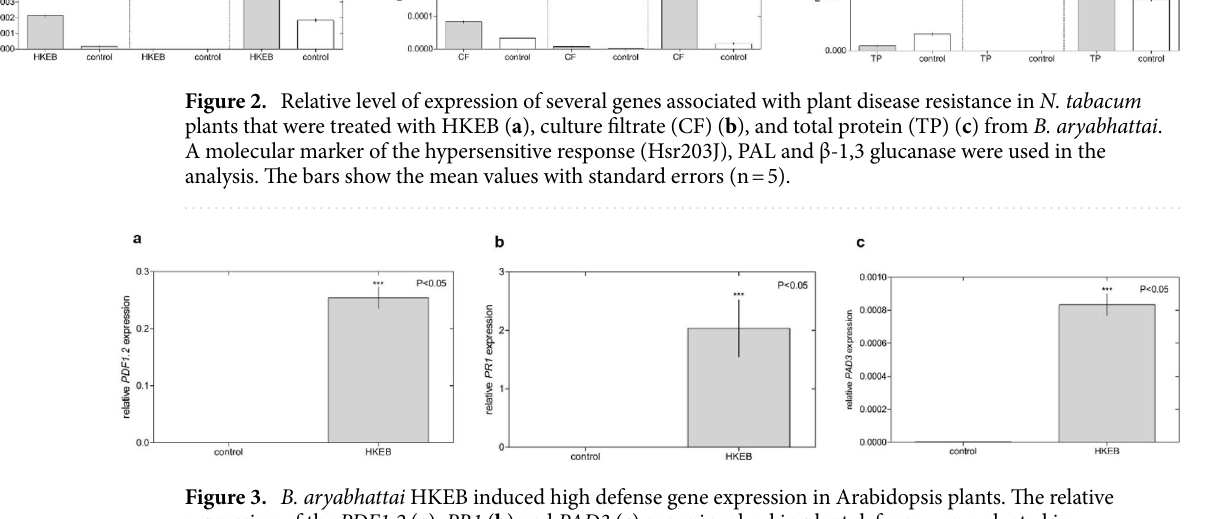
Figure 3. B. aryabhattai HKEB induced high defense gene expression in Arabidopsis plants. The relative expression of the PDF1.2 ( a ), PR1 ( b ) and PAD3 ( c ) genes involved in plant defense was evaluated in Arabidopsis. The bars represent the mean values and standard errors of the means (n = 9). The experiments were replicated three